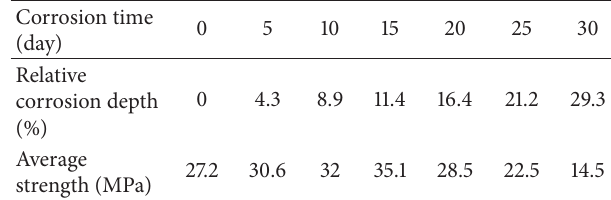
Table 6: Relative corrosion depth and the corresponding average strength of corroded concrete reported in literature [26].